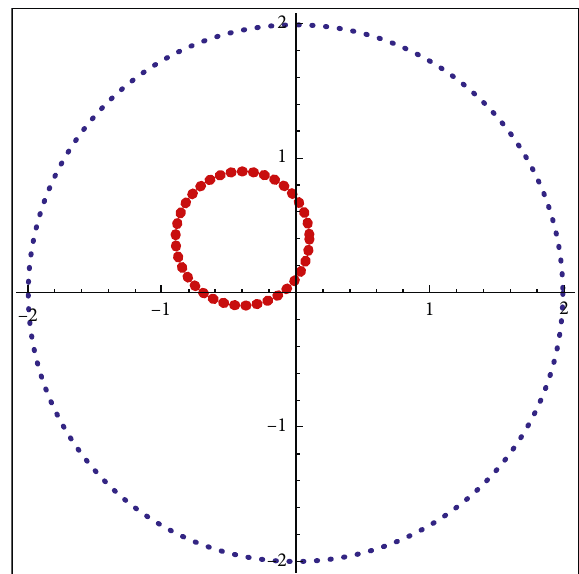
Figure 6: Nonconcentric circles region for Example